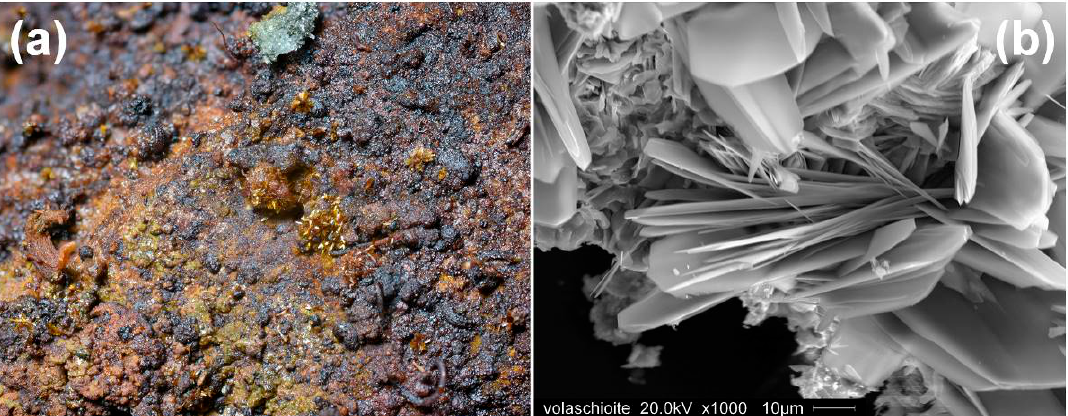
Figure 23. Volaschioite, as μ m-sized yellow-orange crystals on a strongly oxidized surface ( a ) (field of view = 5 mm) and ( b ) SEM image showing the morphology of volaschioite crystals.